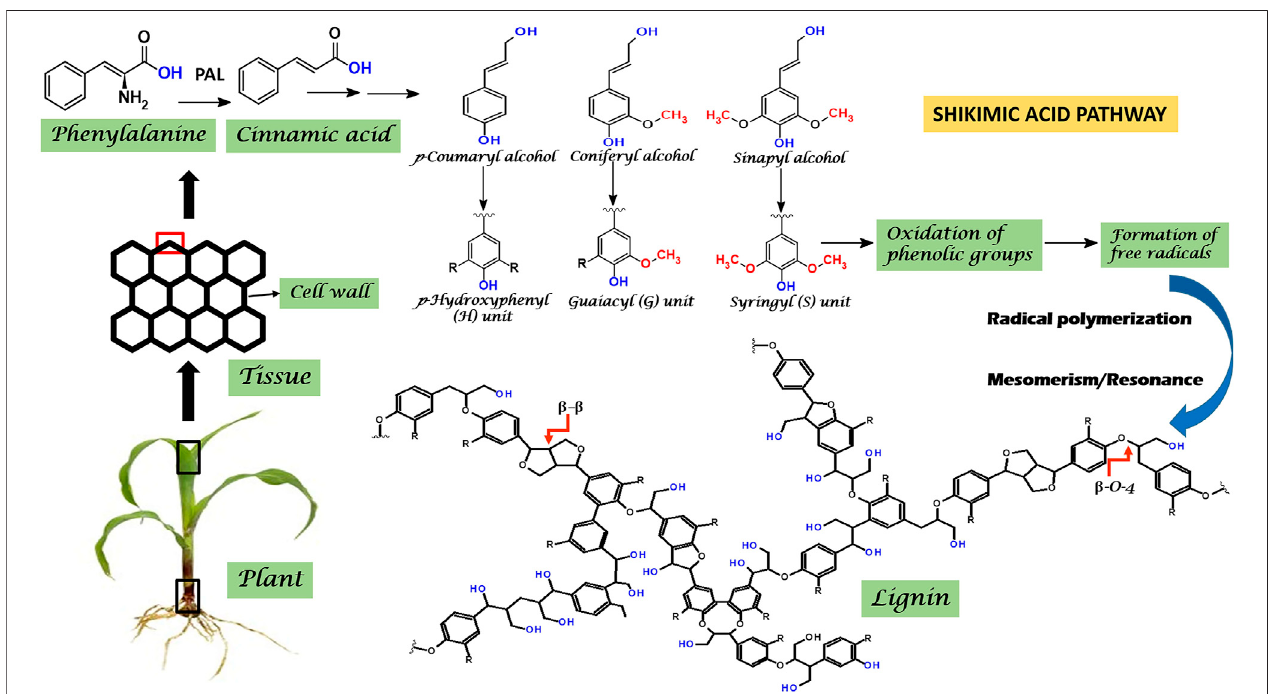
FIGURE 1 | Schematic representation of Shikimic acid pathway involved in lignin biosynthesis. Where PAL, Phenylalanine